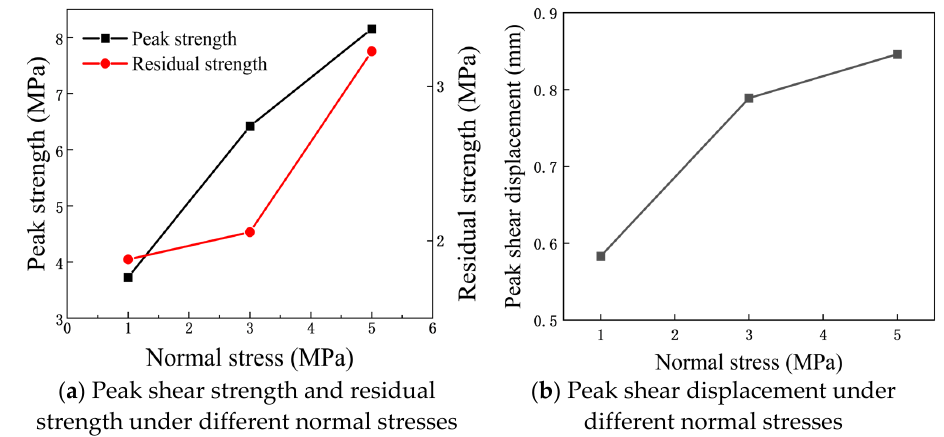
Figure 6. Shear strength curves under different normal stresses at 40° undulating angles.